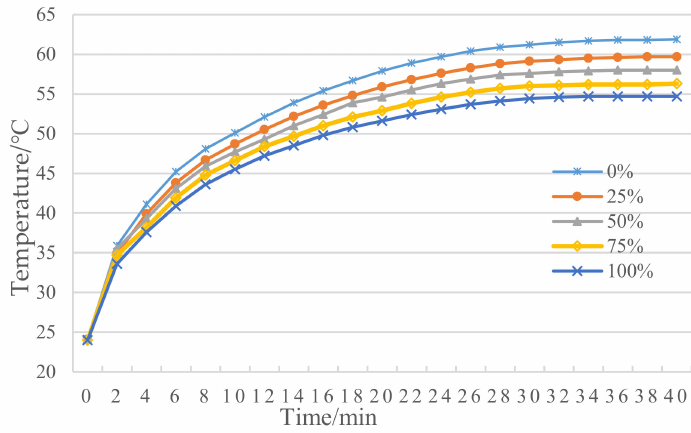
Figure 3. Asphalt slurry radiation test temperature rise curves.